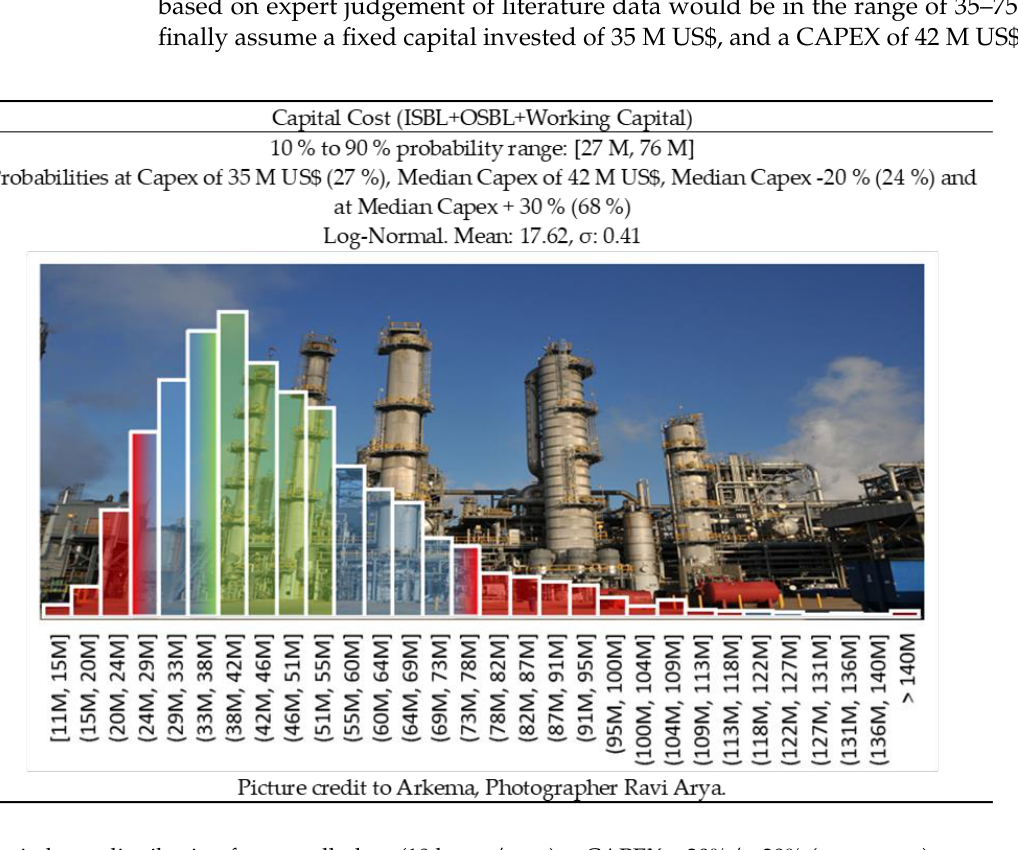
Figure 7. Capital cost distribution for a small plant (10 ktons/year)— CAPEX −20%/+ 30% (green area) corresponds to Class 3 confidence interval of the Association for the Advancement of Cost Engineering (AACE) [73].